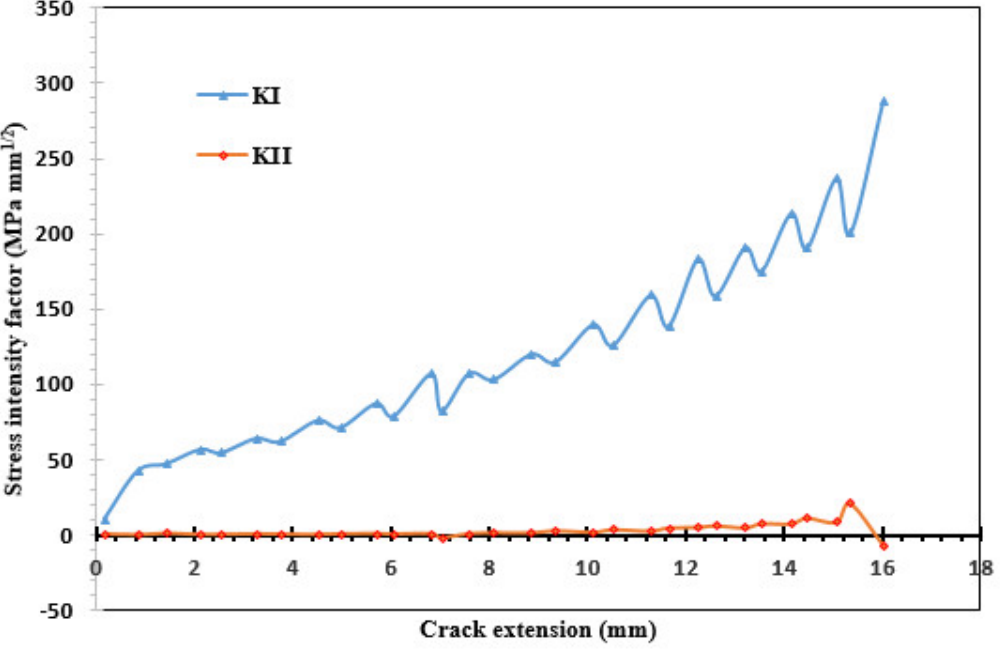
Figure 8. Predicted values of the stress intensity factors.